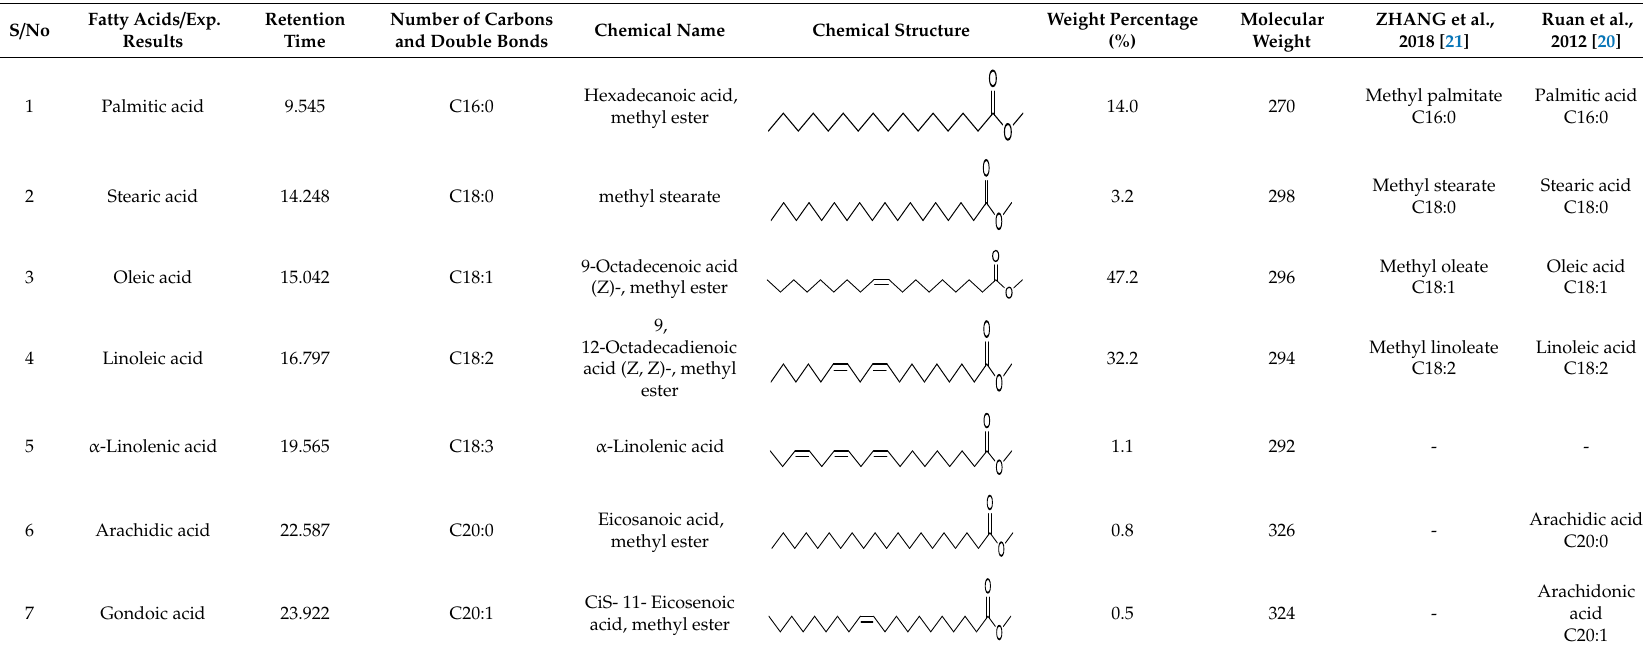
Table 4. The detail fatty acid composition of RT seed oil Biodiesel.